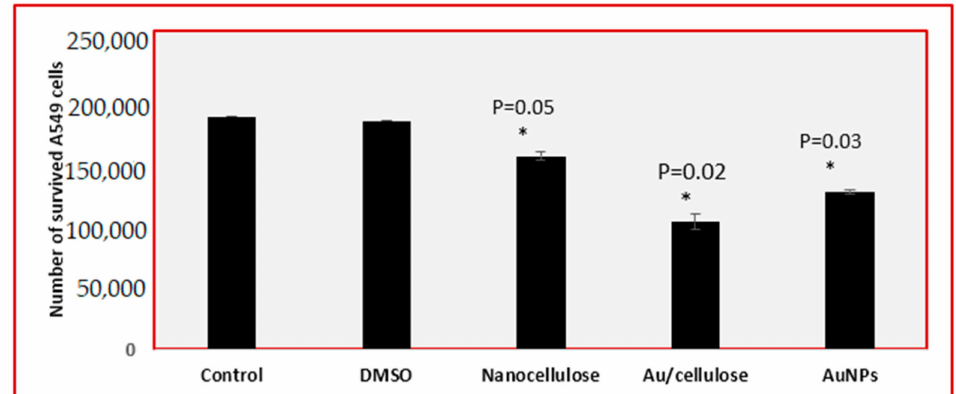
Figure 6. Number of survived A549 cell lines that were pre-treated with 100 µ g/mL AuNPs, nanocel- lulose, and Au/cellulose nanocomposite in comparison with DMSO-treated cells and control cells. * p < 0.05 was considered statistically significant.